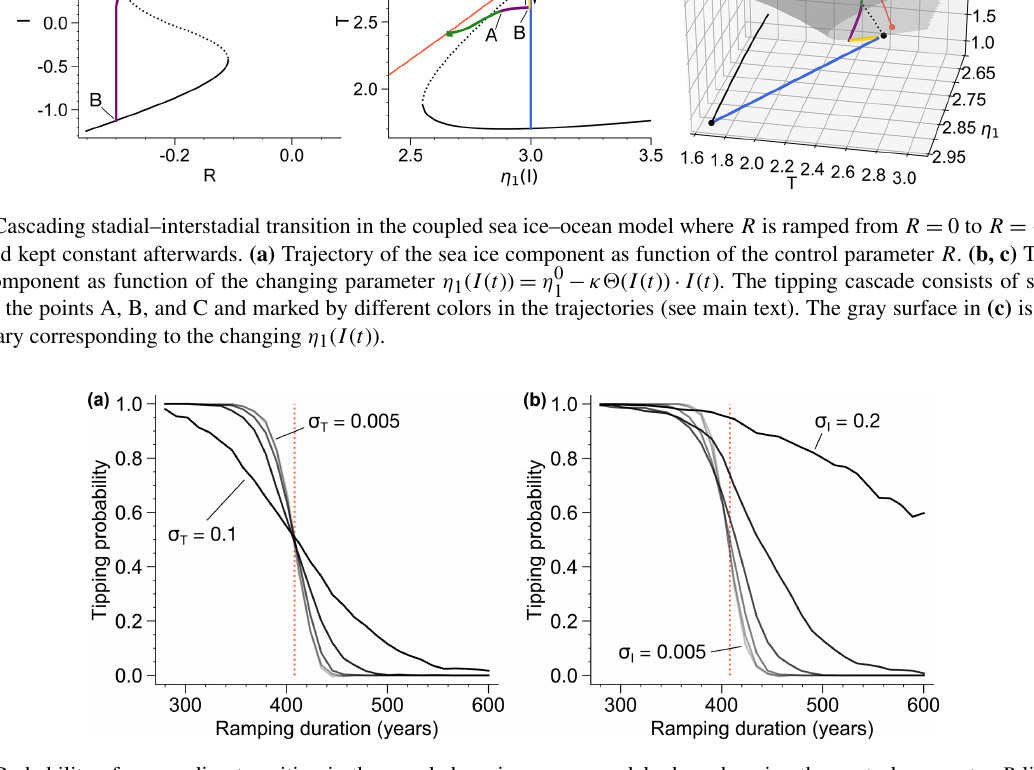
Figure 11. Probability of a cascading transition in the coupled sea ice–ocean model when changing the control parameter R linearly from R = 0 to R = − 0 . 3 within different ramping times. (a) Fixed noise level σ I = 0 . 02 in the sea ice component and varying noise levels σ T = σ S = σ = 0 . 005 (lightest gray), σ = 0 . 01, σ = 0 . 02, σ = 0 . 04 and σ = 0 . 1 (darkest gray) in the ocean component. (b) Fixed noise level σ T = σ S = 0 . 02 in the ocean component and varying noise levels σ I = 0 . 005 (lightest gray), σ I = 0 . 01, σ I = 0 . 02, σ I = 0 . 04, σ I = 0 . 08 and σ I = 0 . 2 (darkest gray) in the sea ice